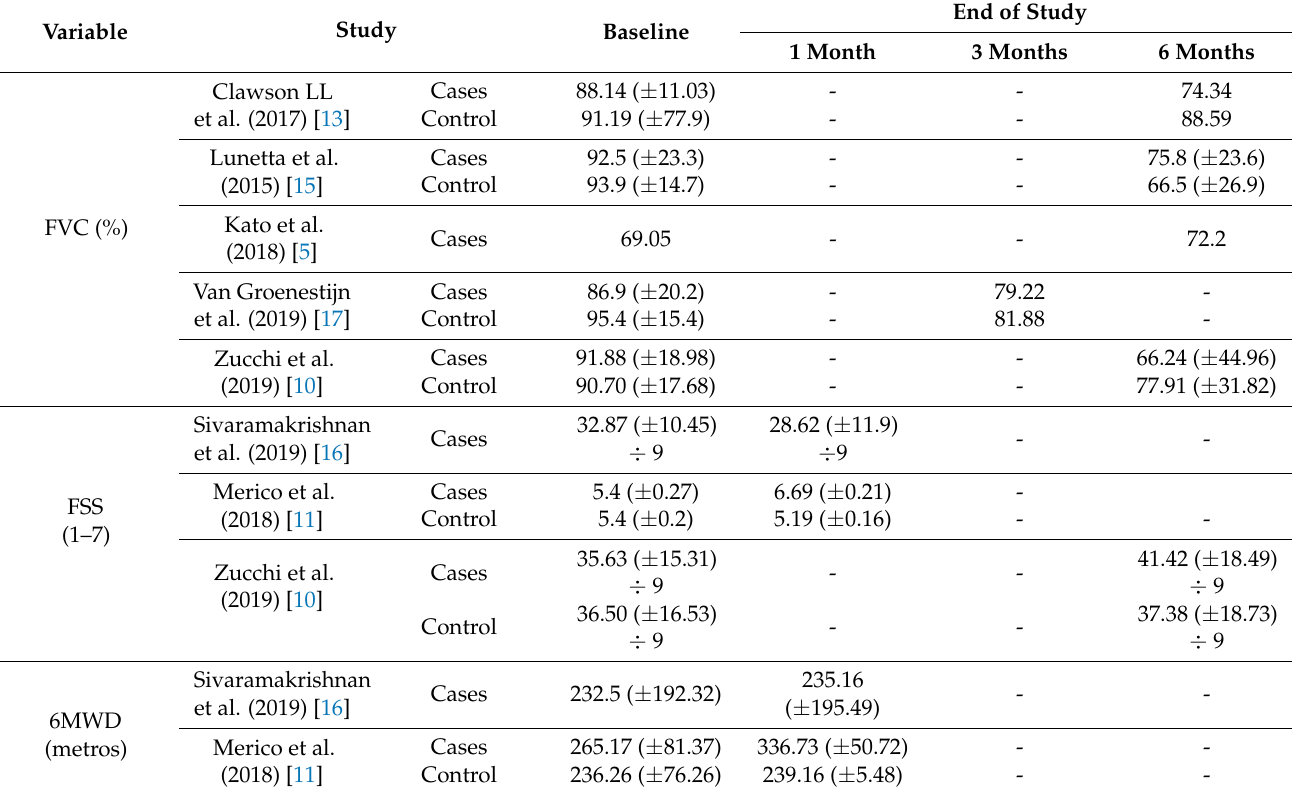
Table 4. Summary of secondary outcome variables FVC, FSS,